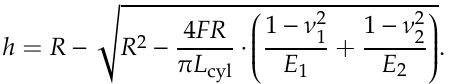
Figure 6. Contact force dependence of structural depth for the SS-processed metal/PET films. Processing conditions: T = 3.09–7.73 N, θ = 150.0°, V = 10.0 mm/min, and L = 1.0 mm.